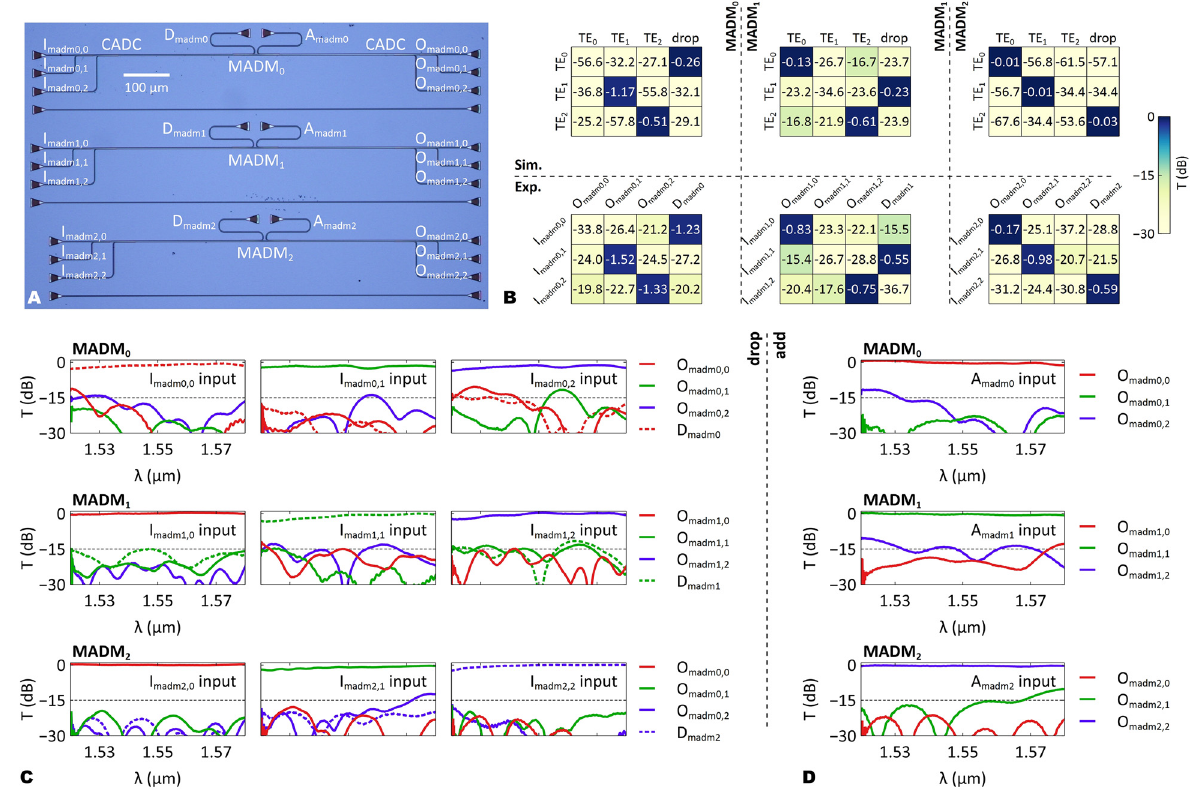
Figure 4: Measurement results for direct-access mode add-drop multiplexers. (A) The optical microscope image of fabricated devices with port identifiers labeled. (B) The calculated (upper row) and measured (lower row) transmittancematricesforMADM 0 (leftcolumn),MADM 1 (middlecolumn)andMADM 2 (rightcolumn)atthe1.55- μ mwavelength.Themeasured transmittance spectra for MADM 0 (upper row), MADM 1 (middle row) and MADM 2 (lower row) as light was launched from (C) input ports and (D) adding ports. MADM, mode add-drop multiplexer; CADC, cascaded asymmetric directional